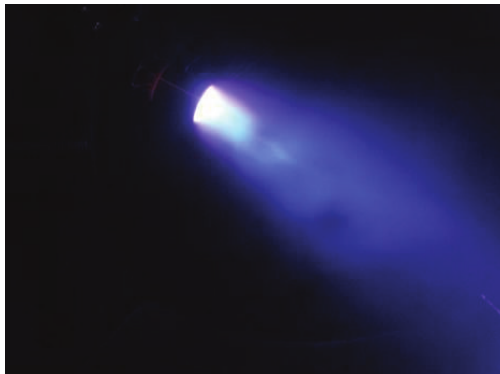
Figure 11: Discharge of a µ PPT during a lifetime